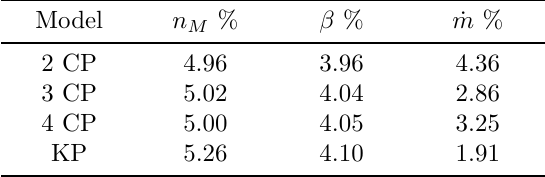
Table 2: Percentages of Parameters and flow rate Model